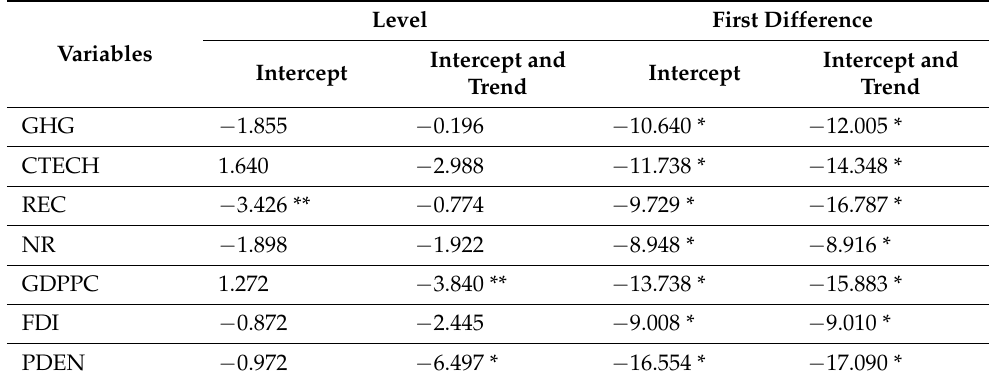
Table 4. Phillips and Perron Unit Root Estimates.